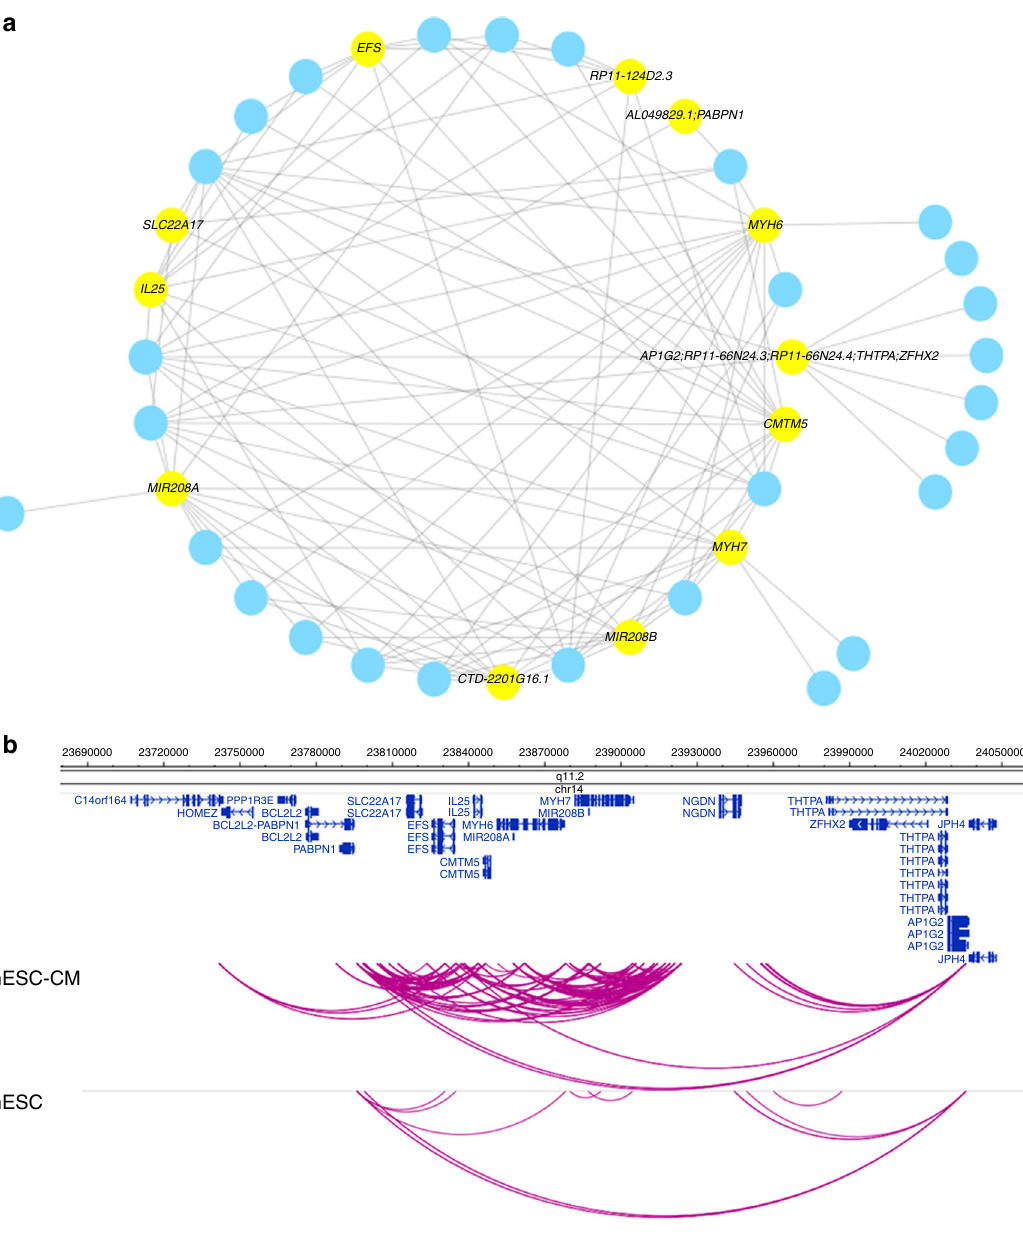
Fig. 4 Network analyses of the top 20% hESC-CM promoter interactions after differentiation. a The promoter – cPIR subnetwork with the highest average degree among the top 20% promoter interactions for read counts, occurring in the MYH6 region having 40 nodes, including 12 promoter nodes (yellow) and 28 cPIR nodes (blue), and 117 edges. b Reorganisation of the MYH6 network between the states of hESCs and